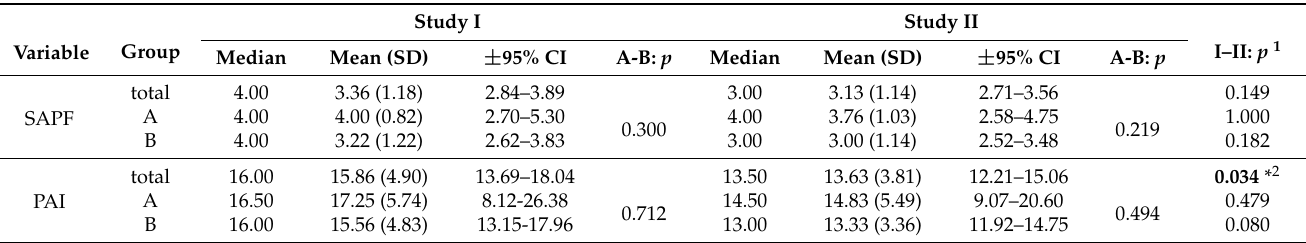
Table 1. Self-assessment of physical fitness and physical activity: Study I and Study II.